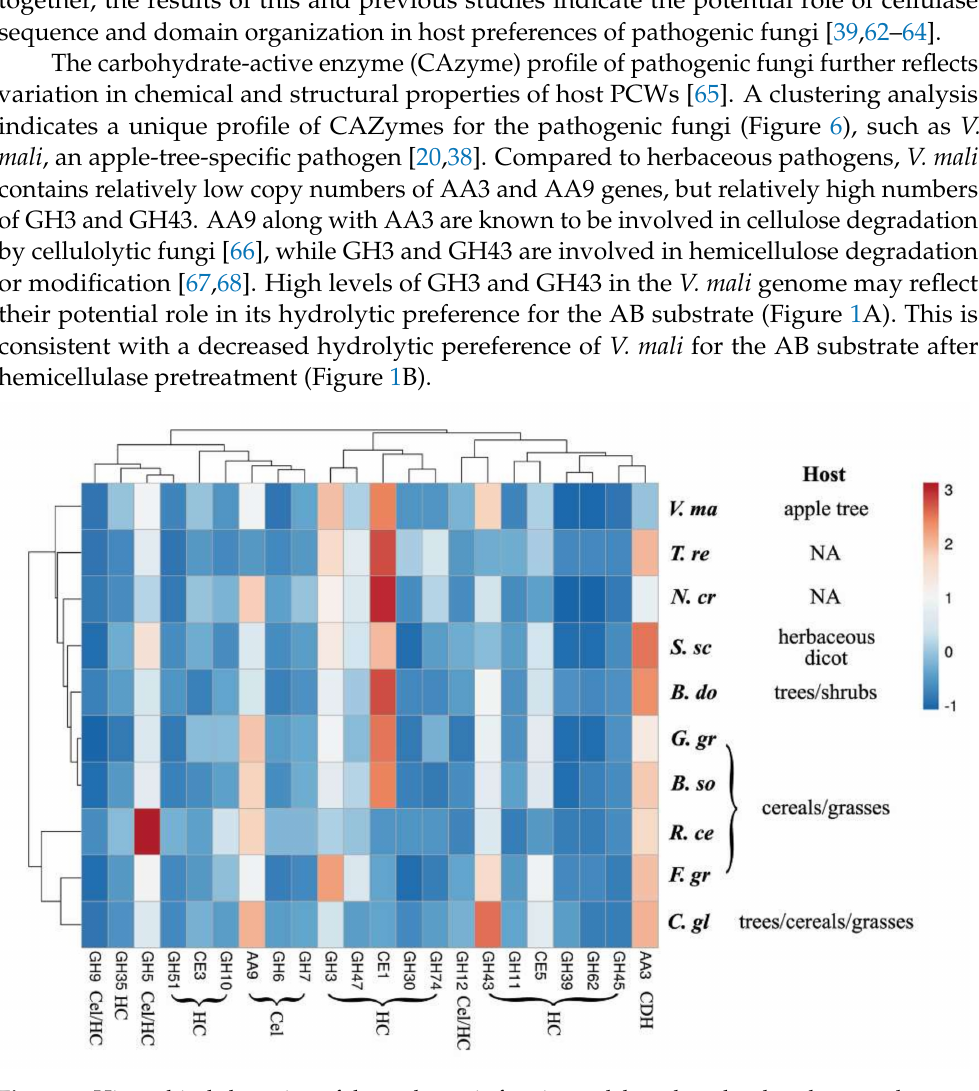
Figure 6. Hierarchical clustering of the pathogenic fungi tested, based on the abundance and compo- sition of CAZyme classes. Heatmap shows the relative abundance of each CAZyme class. CAZymes categories include Glycoside Hydrolases (GHs), Carbohydrate Esterases (CEs), and Auxiliary Activi- ties enzymes (AAs). Catalytic activities of the CAZymes include cellulase (Cel), hemicellulase (HC), and cellobiose dehydrogenase (CDH). The AA9 family consists of lytic polysaccharide monooxyge- nases (LPMOs) involved in cellulose degradation. A detailed description of the CAZymes is available on the CAZy database (http://www.cazy.org, accessed on 16 November